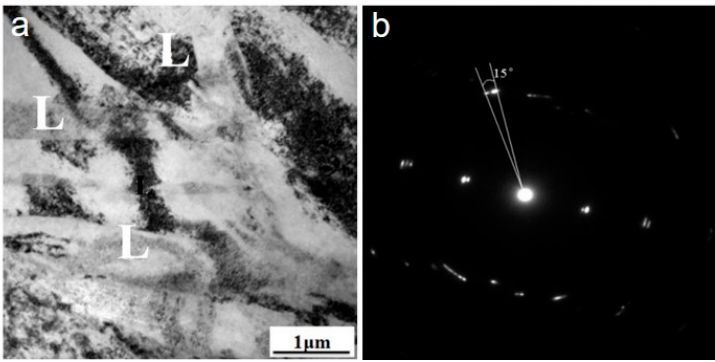
Figure 3. Transmission electron microscopy images of sample F-12. ( a ) bright field imagee; ( b ) selected oodiffraction pattern of a micro shear band.